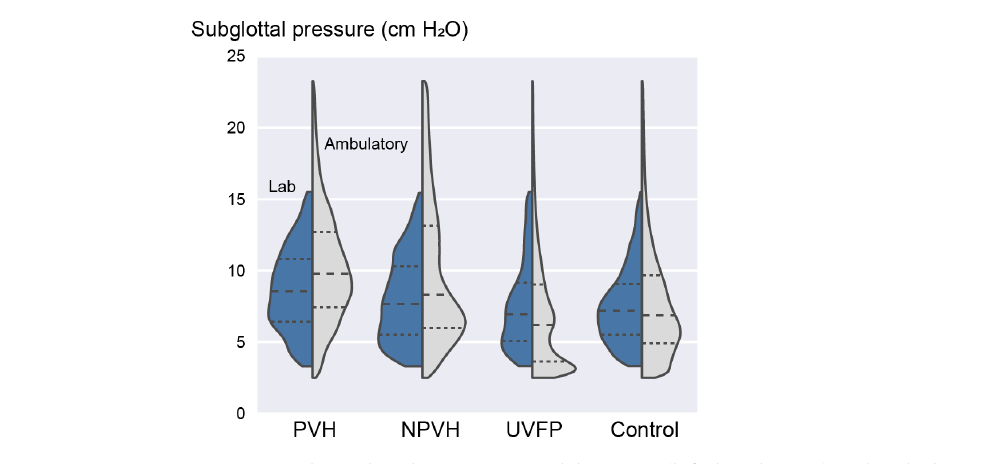
Figure 6. Split-violin plots comparing laboratory (left distribution) and ambulatory (right distribution) estimates of Ps within each participant group using Ps Estimation Method 3.